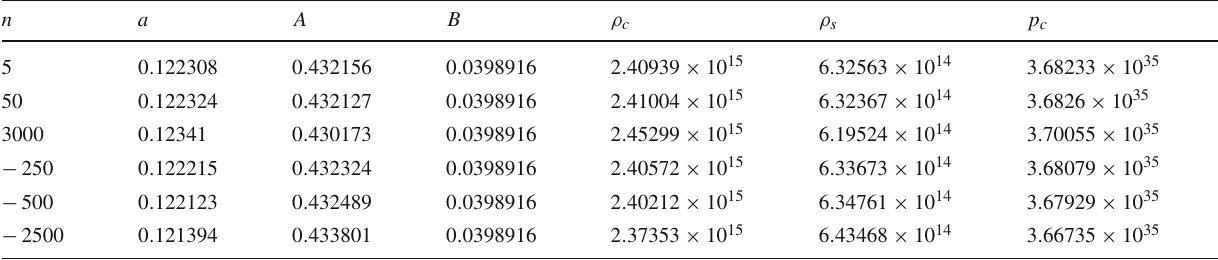
Table 1 The numerical values of a , A , B , central density (ρ c ) , sur- face density (ρ s ) , central pressure ( p c ) are obtained by fixing b = 0 . 0095 for a compact star of mass M = 1 . 85 M (cid:3) and radius = 9 . 5